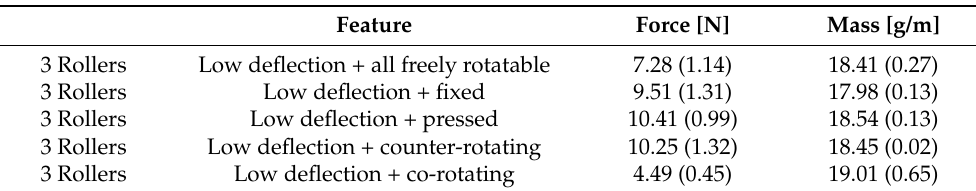
Table 6. Yarn pulling force and mass/length ratio of fresh MCFs made with varied roller rotation: average values, standard deviations in